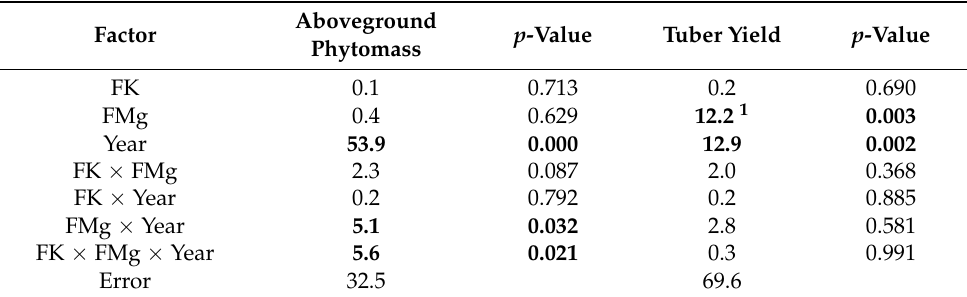
Table 3. ANOVA results: factor contribution (%) to the total variance of potato aboveground phytomass and tubers in the microplot field experiment with potassium (FK) and magnesium fertilization